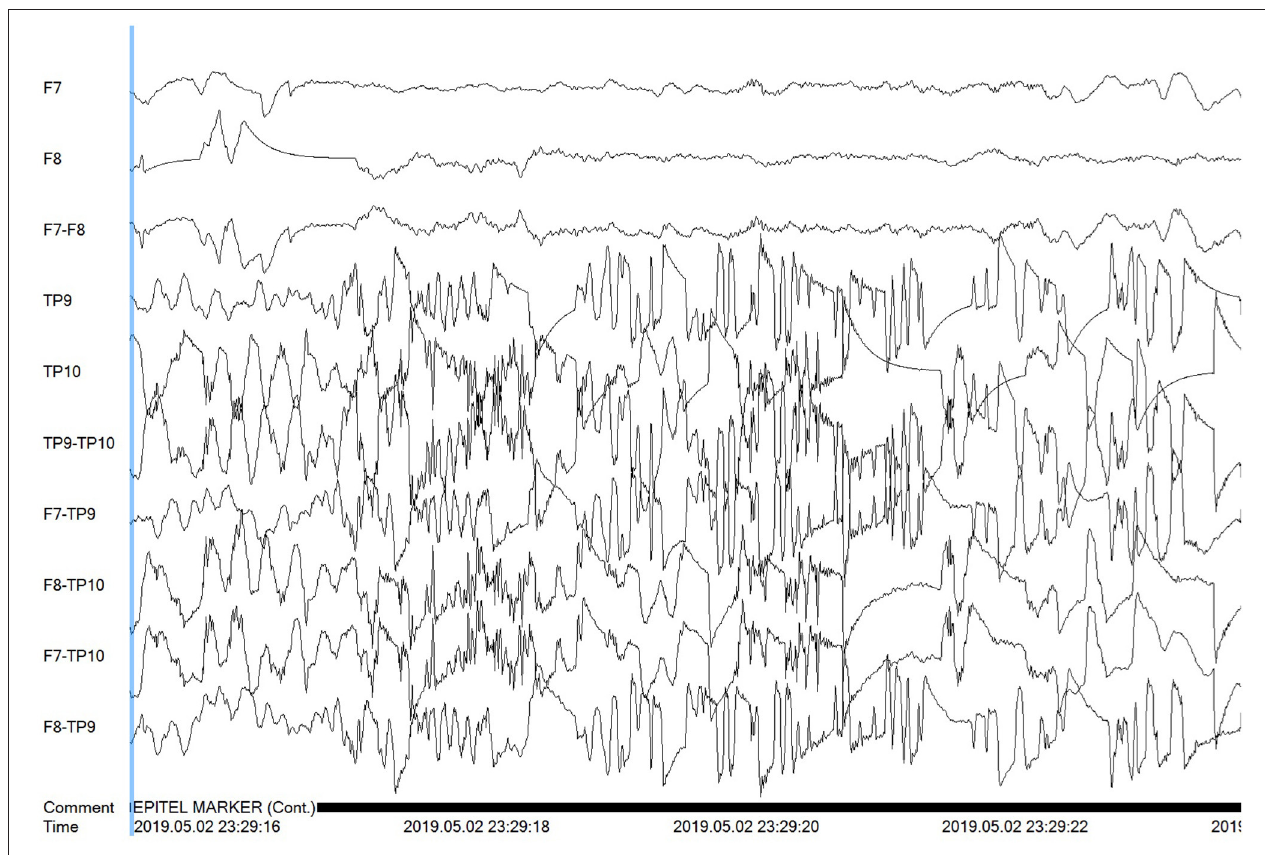
FIGURE 7 | Poor signal quality is shown for the Tp9 and Tp10 Epilog sensors on Subject #9 during a false positive algorithm detection